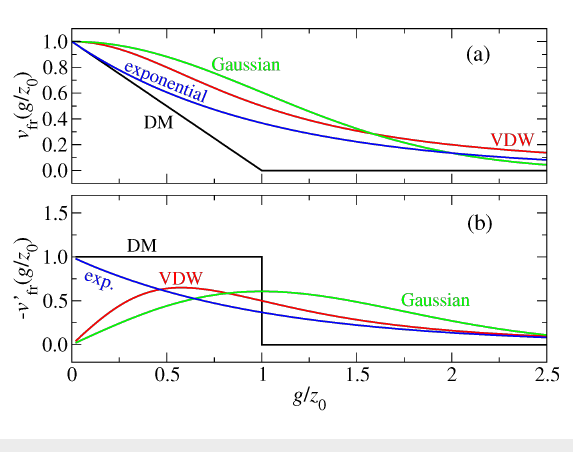
Figure 2: (a) Finite-range surface energies and (b) forces per unit area for the models investigated in this study.